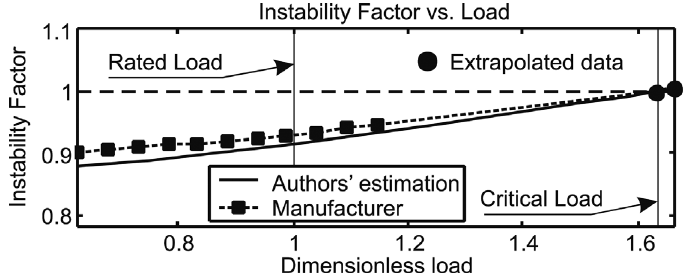
Fig. 20. Instability Factor associated with the eigenvalue n.3 plotted vs. the dimensionless